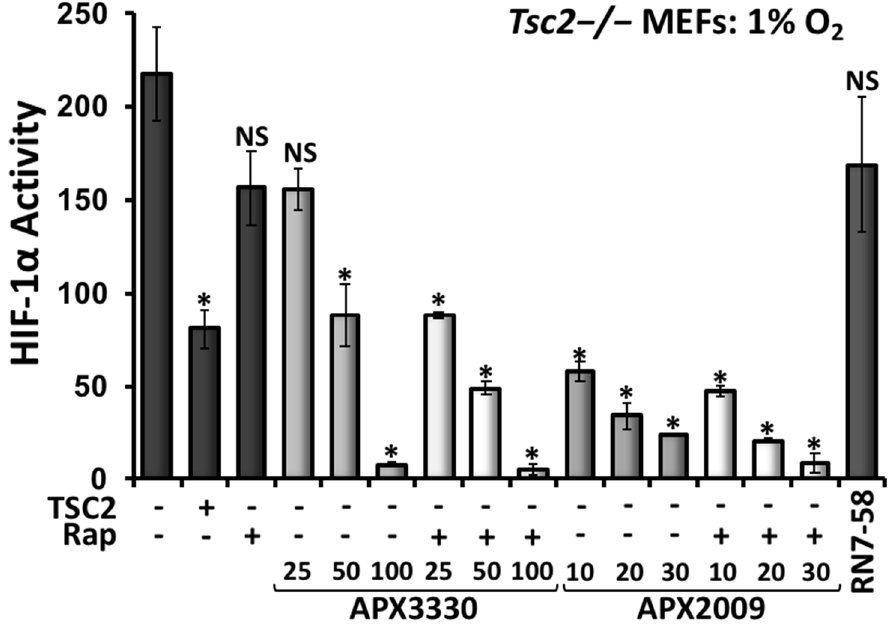
Figure 7. The second-generation Ref-1 inhibitor APX2009 potently inhibited HIF-1 α , while rapamycin was less effective. Tsc2 − / − MEFs were transiently transfected with the HIF-1 α luciferase vector (and the TSC2/pcDNA3.1 vector as a control, where indicated). These cells were subjected to hypoxia (1% O 2 ) for 18 h in the presence of DMSO, 50 nM rapamycin, APX3330 (25, 50 and 100 µ M), or APX2009 (10, 20, and 30 µ M), or 100 µ M RN7-58 (control drug) as single agents, or where indicated, rapamycin was combined with APX3330 and APX2009. Luciferase assays to determine HIF-1 α activity were carried out ( n = 3). Error bars represent SDs; * p < 0.05, ** p < 0.01, *** p < 0.001 when compared to the untreated DMSO control.